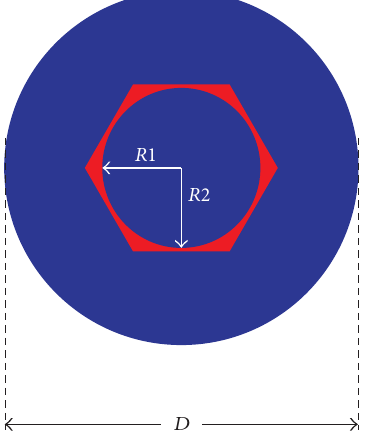
Figure 2: Simulation model of the wave splitter based on graphene. The red zone is the ENZ graphene layer, and the blue zone is the graphene with negative dielectric permittivity to support the propagation of SPP